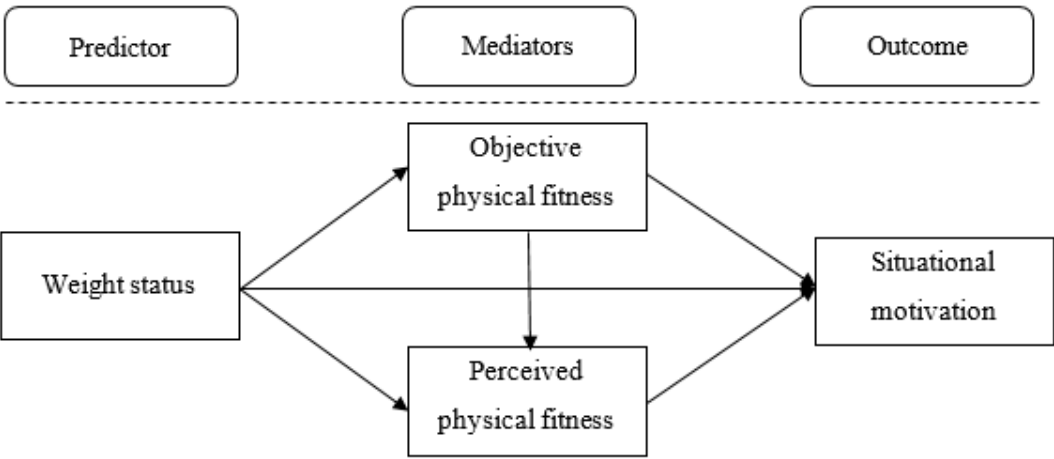
Figure 1. Multiple mediation model of the relationship between weight status and motivation during fitness testing in physical education with objective and perceived physical fitness as mediators.